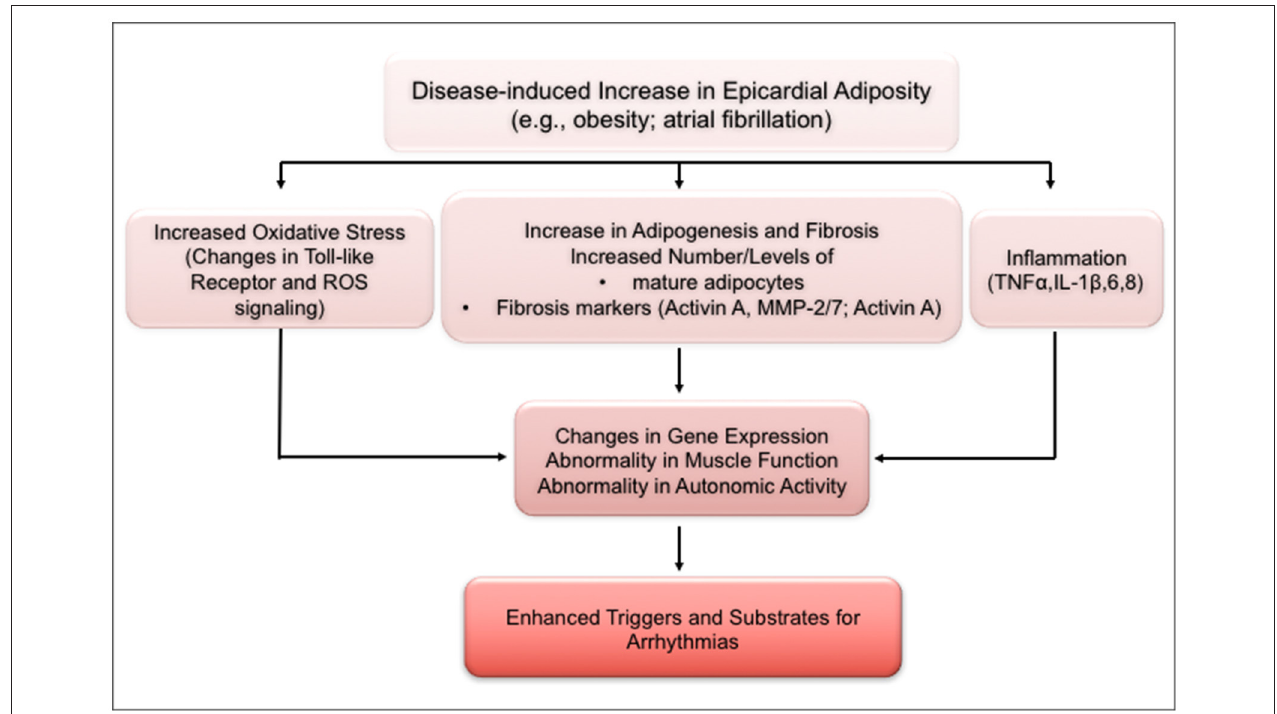
FIGURE 4 | Schematic of mechanisms underlying increased arrhythmogenic risk with increased excess adiposity. ANS, autonomic nervous system; IL, interleukin; MMP, matrix metalloproteinase; ROS, reactive oxygen species; TLR, toll-like receptor; TNF, tumor necrosis factor. (Modified from Pandit et al.,